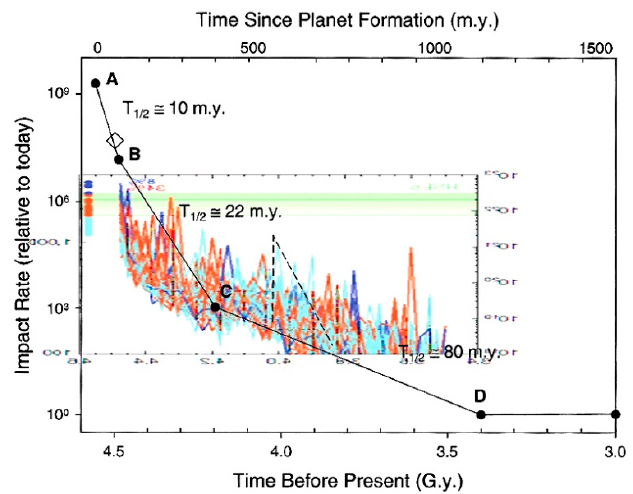
Figure 13. A numerical model from Marchi et el. (2014 [158], colored data) showing computed decay curves of impact rate from main belt asteroids, is here superimposed on a graph by Hartmann et al. (2000 [35]) showing early-proposed lunar flux curve (ABCD) based on crater counts after 3.9 Ga ago, and extrapolated back before 4.0 Ga ago with theoretically estimated half-lives (background larger diagram). Marchi graph (small diagram) was reversed left to right so that time flows from left to right as in larger diagram. Scales of the time axis and the impact rate were adjusted in Photoshop to be equal. (Diagram by W.K.H., presented at 2014 history session at DPS [Division of Planetary Sciences, American Astronomical Society], but not published).